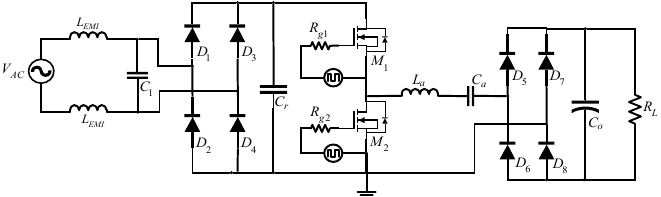
Figure 1. High power factor LC series resonant converter implemented to test the performance of magnetic cores made of resin/iron powder composite material.